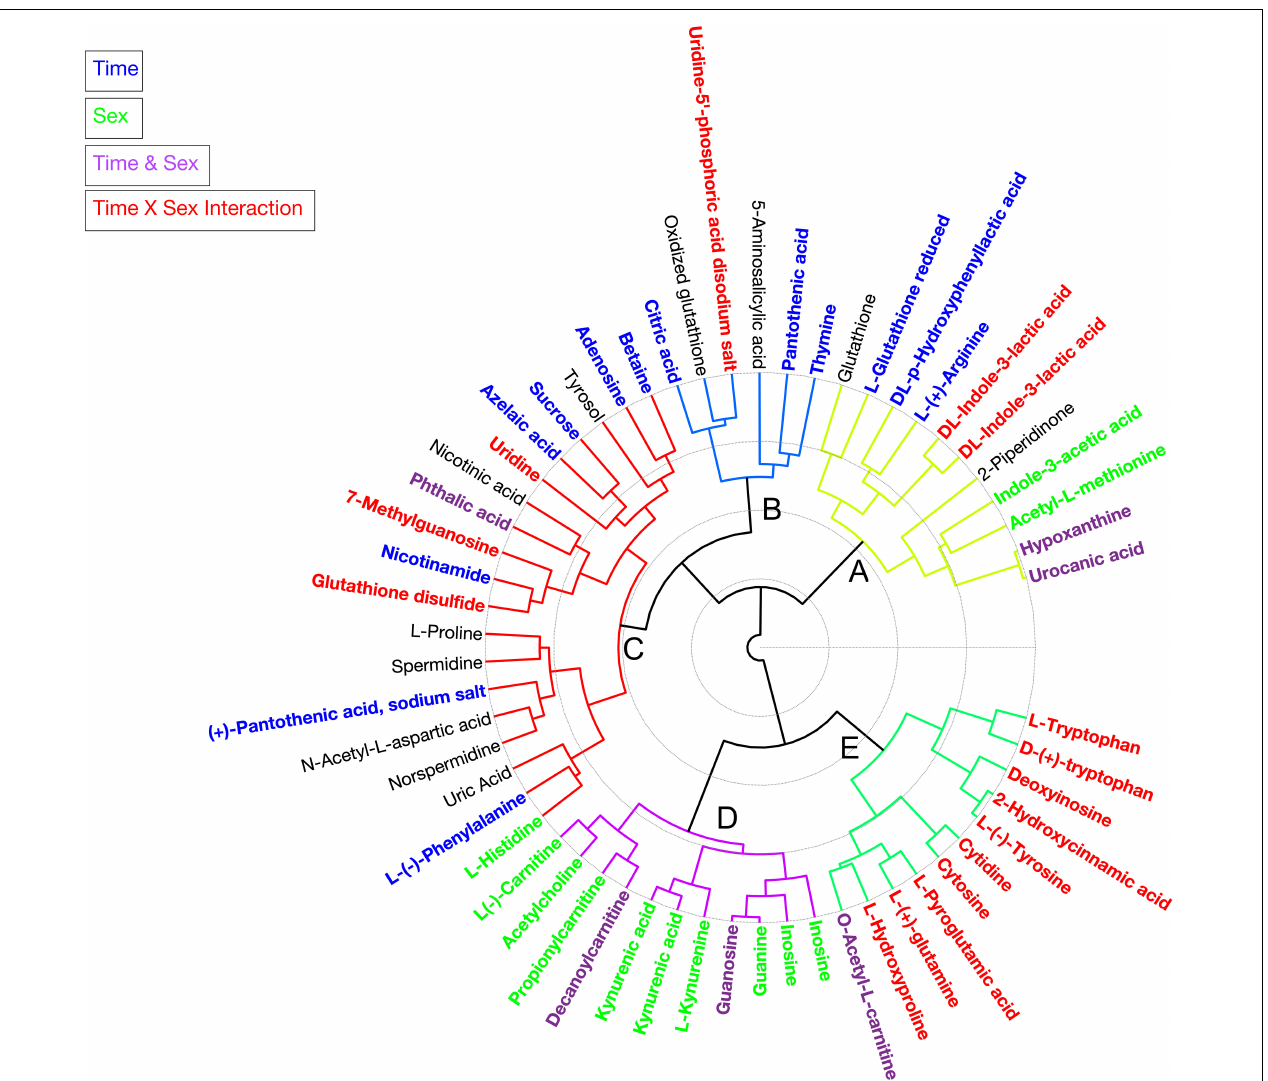
FIGURE 2 | Circular hierarchical cluster analysis (HCA) dendrogram grouping individual metabolites identified in the haemolymph of Cherax tenuimanus into five clusters (A–E) based on phenotypic similarity. Colours of the metabolite name are based on the univariate analysis ( q -value < 0.05), metabolites that are significant over time (blue), between sexes (green), time and sex (purple), time × sex interaction (red), and not significant for any factor (black). Duplicate metabolites identified in positive and negative modes including L- and